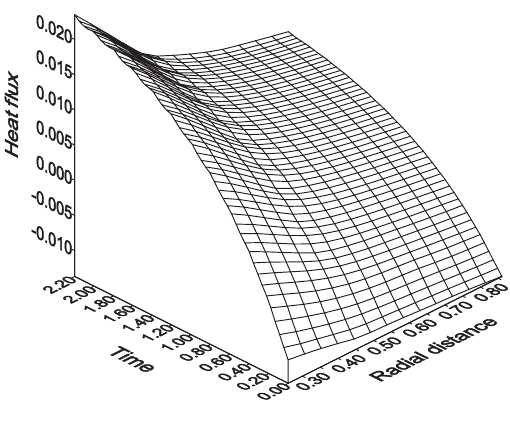
Figure 4.5 . Variation of the pressure with radial distance and time.